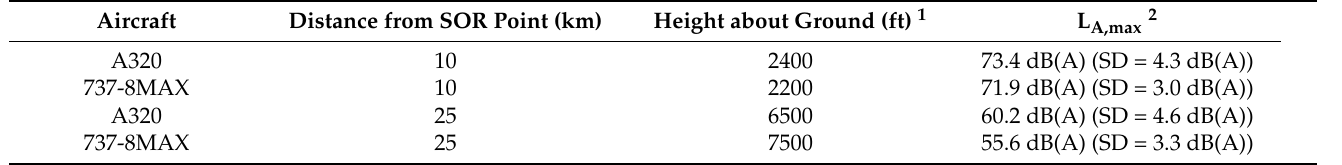
Table 1. L A,max values at 10 km and 25 km from the Start-of-Roll (SOR) point for both an Airbus A320 and Boeing 737-8MAX.